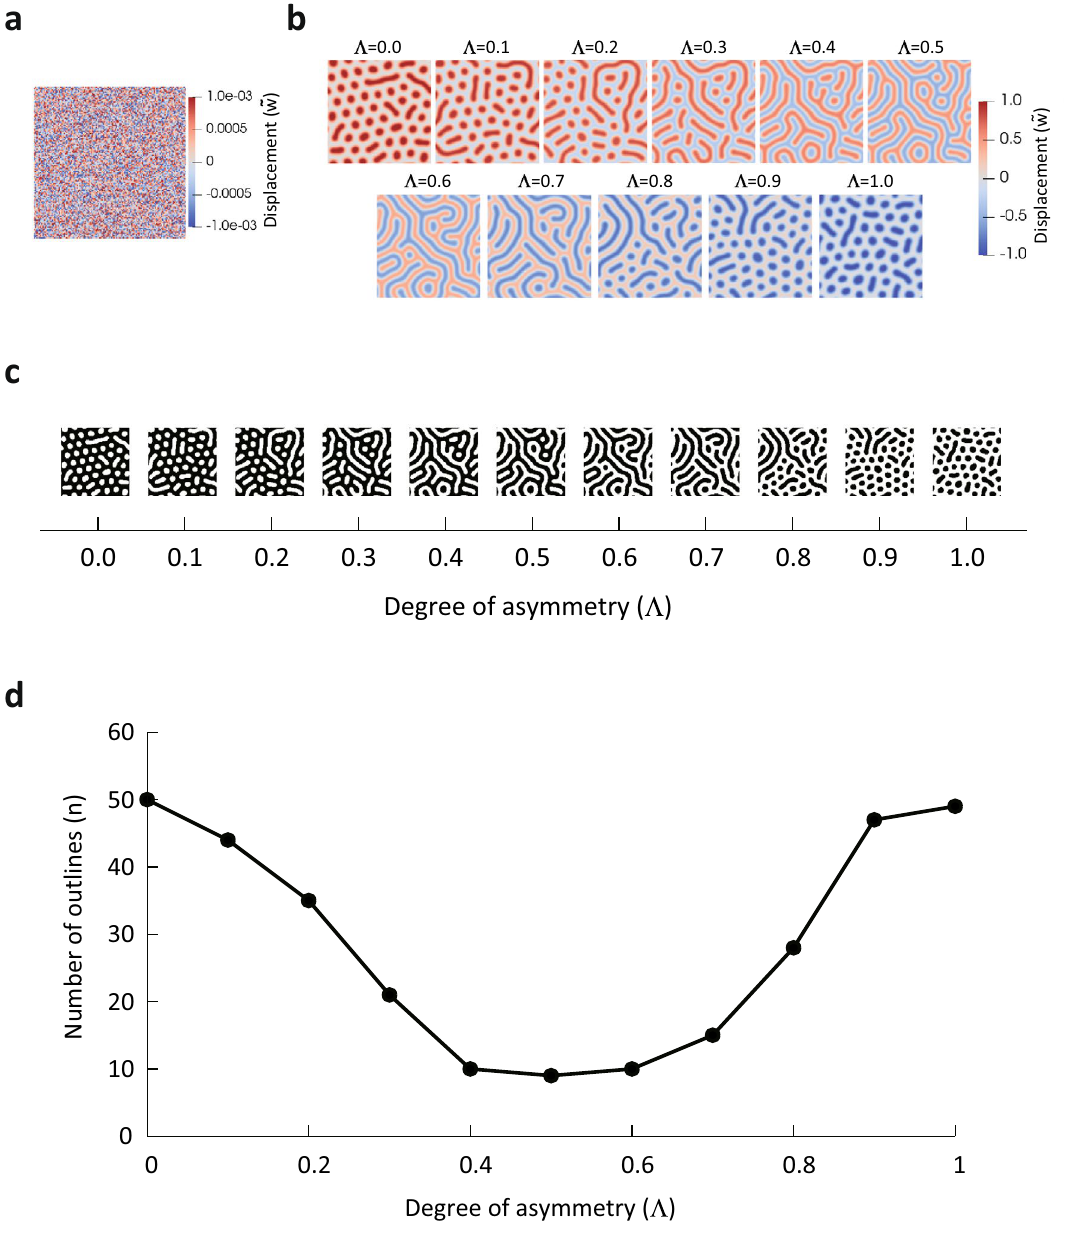
Figure 6. Simulation results for the mechanical model derived from the energy functional. ( a ) Initial state of displacement field ˜ w . ( b ) Snapshots of displacement field ˜ w under the conditions of (cid:31) = 0.0 to 1.0 at time t = 2,000,000. ( c ) Binarized black-and-white images of the simulation results. ( d ) Relation between degree of asymmetry (cid:31) and number of